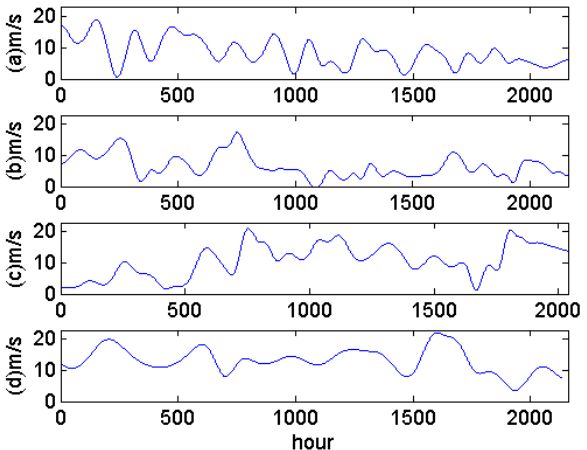
Figure 5. New residual functions of wind speeds (m/s) during the four seasons: ( a ) spring; ( b ) summer; ( c ) autumn; and ( d ) winter.